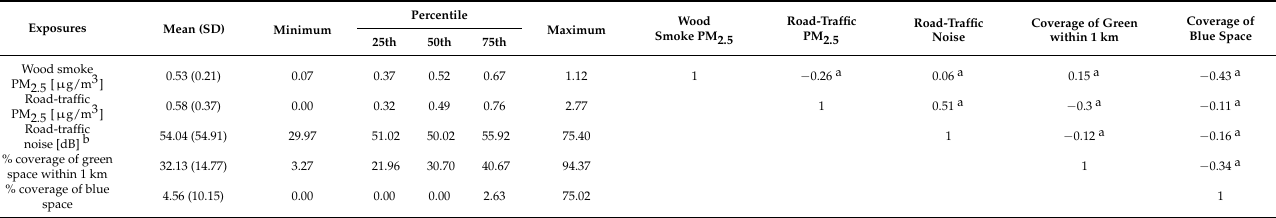
Table 2. Summary values and Spearman’s correlation matrix for urban environmental exposures.